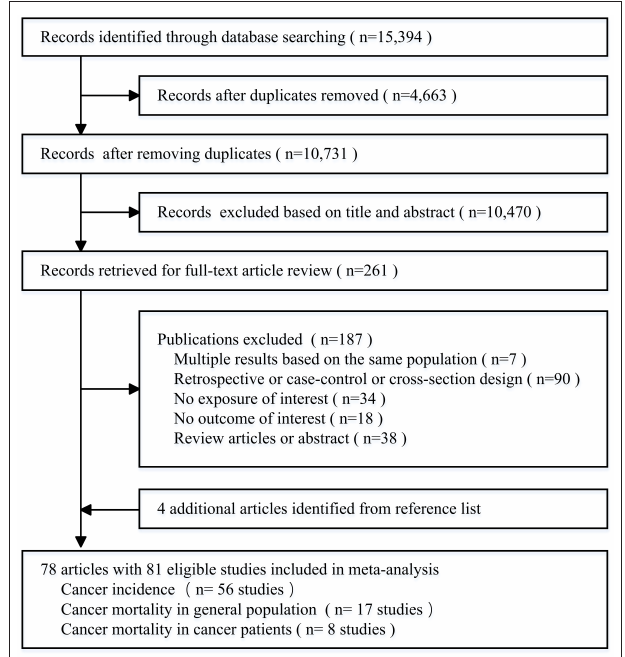
FIGURE 1 | Flow diagram of study